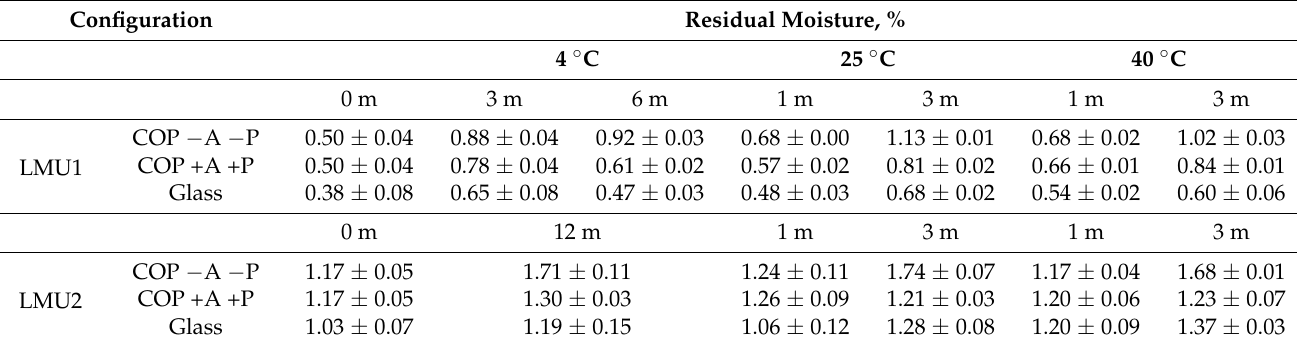
Table 1. Residual moisture results of the lyophilizates stored at different temperatures for the respective time. Configuration